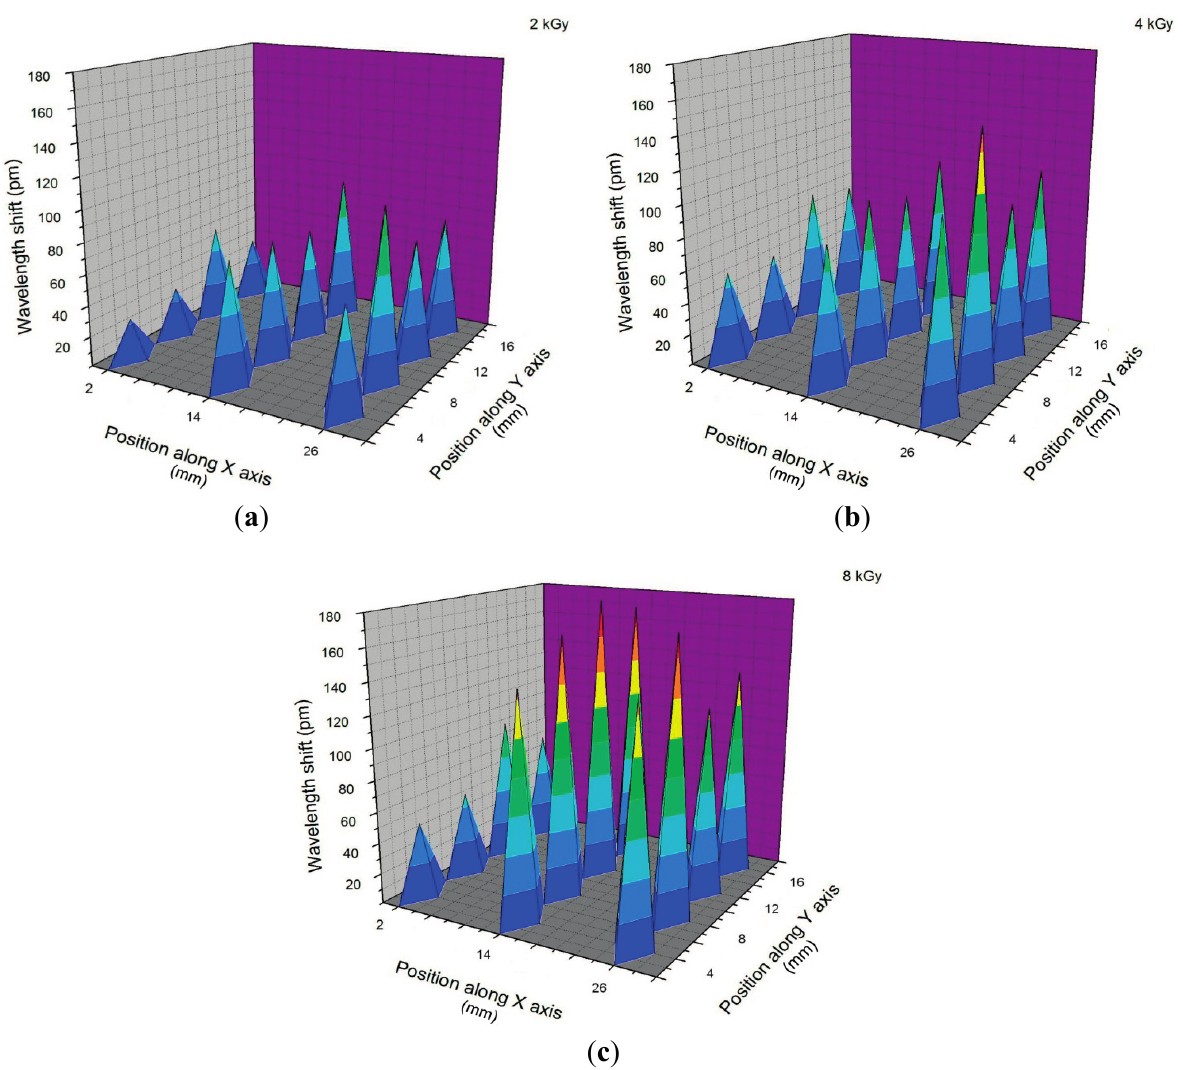
Figure 5. Illustration of the three dimensional (3D) reconstruction of the deployed energy on the FBG array at: ( a ) 2 kGy; ( b ) 4 kGy; ( c ) 8